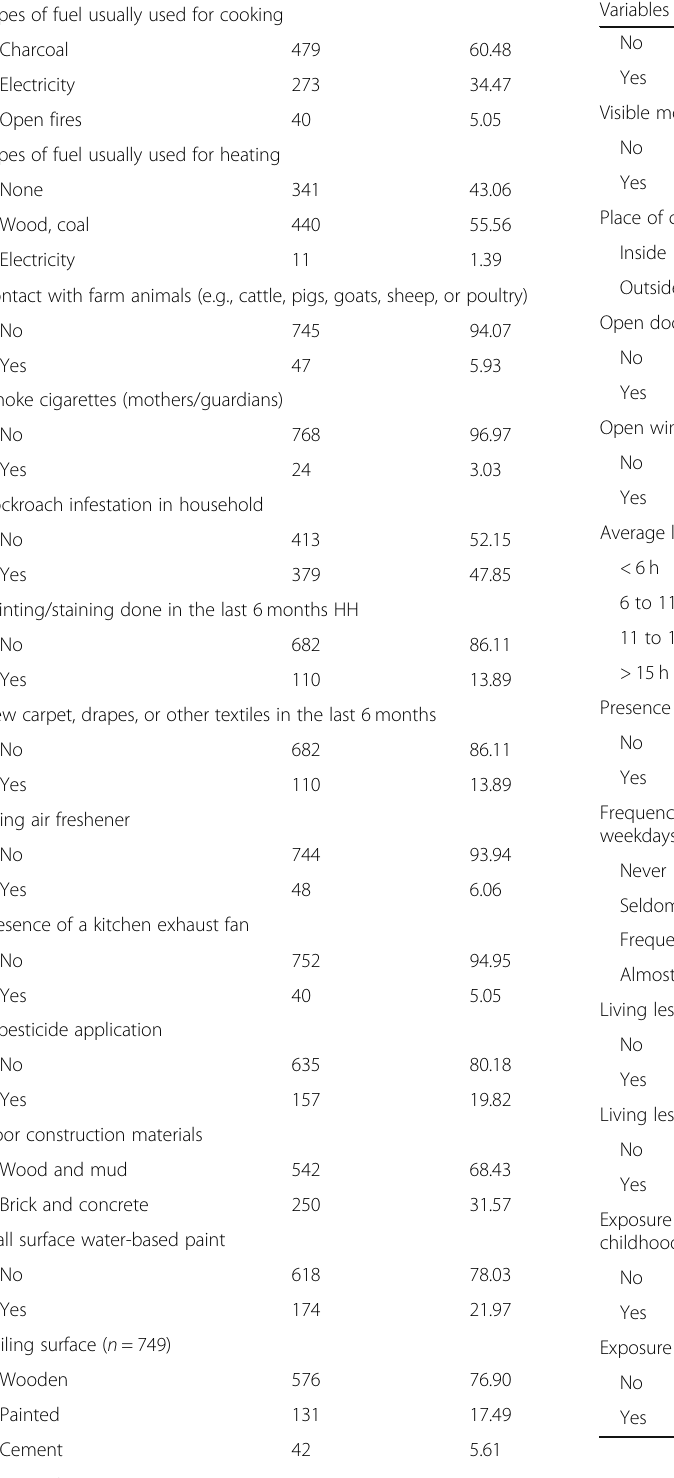
Table 2 Household air pollution and housing characteristics of